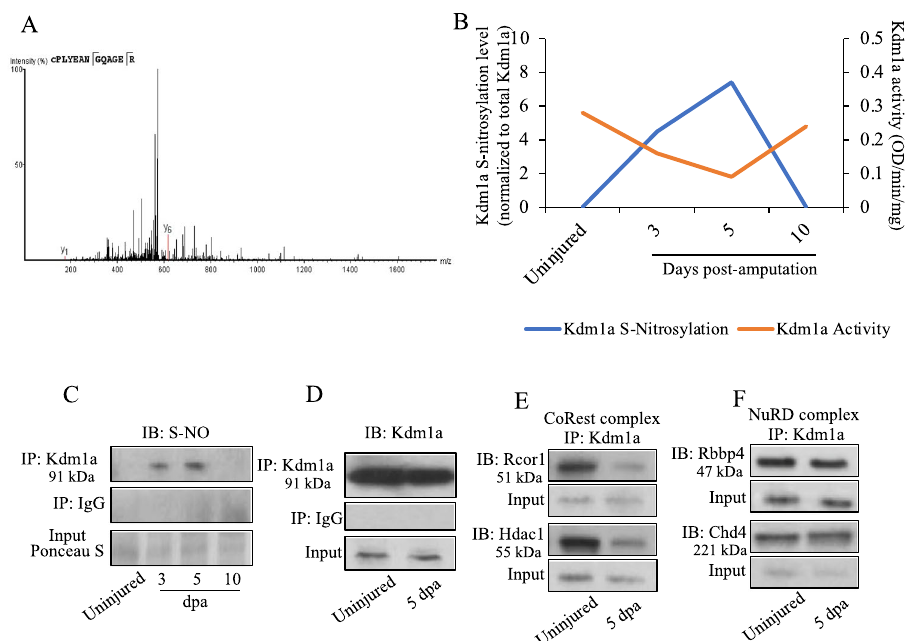
Fig. 3 Role of S-nitrosylation of Kdm1a in tail fi n regeneration in adult zebra fi sh. A MS/MS fragmentation spectrum for the Cys334-containing peptide of Kdm1a. Peptide sequence is shown at the top left of the spectrum, with the annotation of the identi fi ed matched amino terminus-containing ions (b ions) in black and the carboxyl terminus-containing ions (y ions) in red. The spectrum con fi rms the identity of the peptides CPLYEAN and the labeled C as S-nitrosylated cysteine. B Line graph reporting the quanti fi cation of Kdm1a S-nitrosylation (normalized by total Kdm1a) and Kdm1a activity during tail fi n regeneration. C Western blotting (WB) for S-nitrosylated Kdm1a in uninjured and at 3, 5, and 10 dpa. Samples were previously immunoprecipitated (IP) for Kdm1a. IP with IgG and input were used as controls. D – F WB for Kdm1a, CoRest and NuRD complexes components following IP with Kdm1a antibody in tail fi n uninjured or injured at 5 dpa. Dpa days post-amputation. N = 3 biological